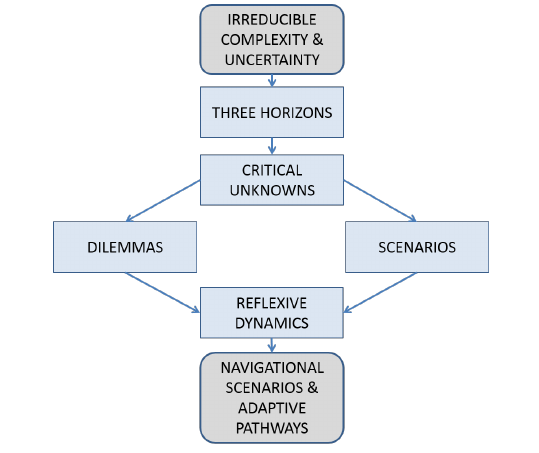
Fig. 5 . An example of the way Three Horizons (3H) can frame the use of other tools. It depicts the flow of a recent project led by one of the authors that explored how carbon pricing could be used to help drive the transformation of the world economy to a low carbon future. From the initial 3H exploration, the critical unknowns of approach were explored with both dilemmas and scenarios, which led to an understanding of the adaptive pathways to the third